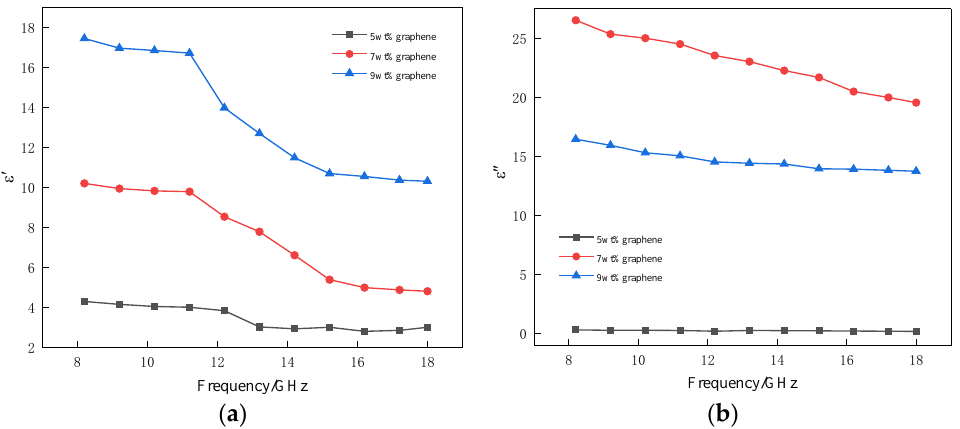
Figure 2. Complex permittivity of graphene/PLA composite absorbers with different graphene content. ( a ) The real part of the complex permittivity; ( b ) the imaginary part of the complex permittivity.